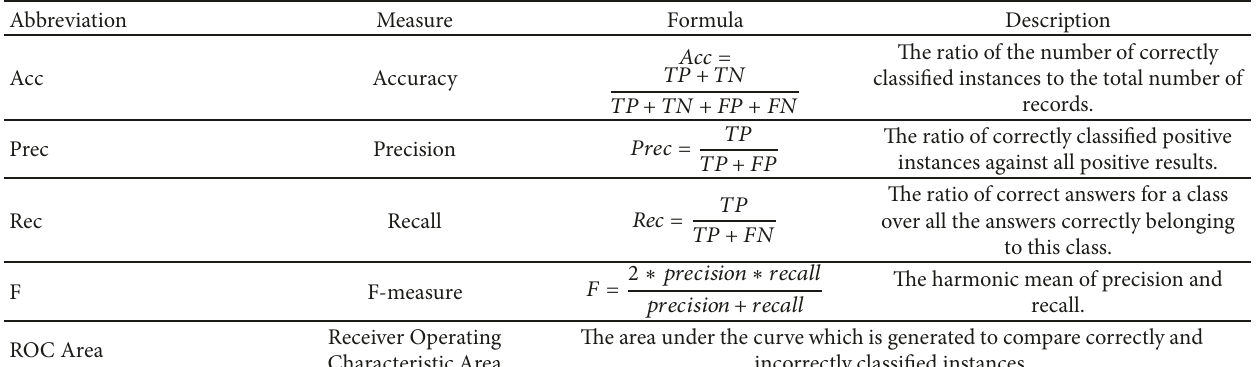
Table 2: The detailed information about classifier performance measures. (TP: true positives, FP: false positives, TN: true negatives, and FN: false